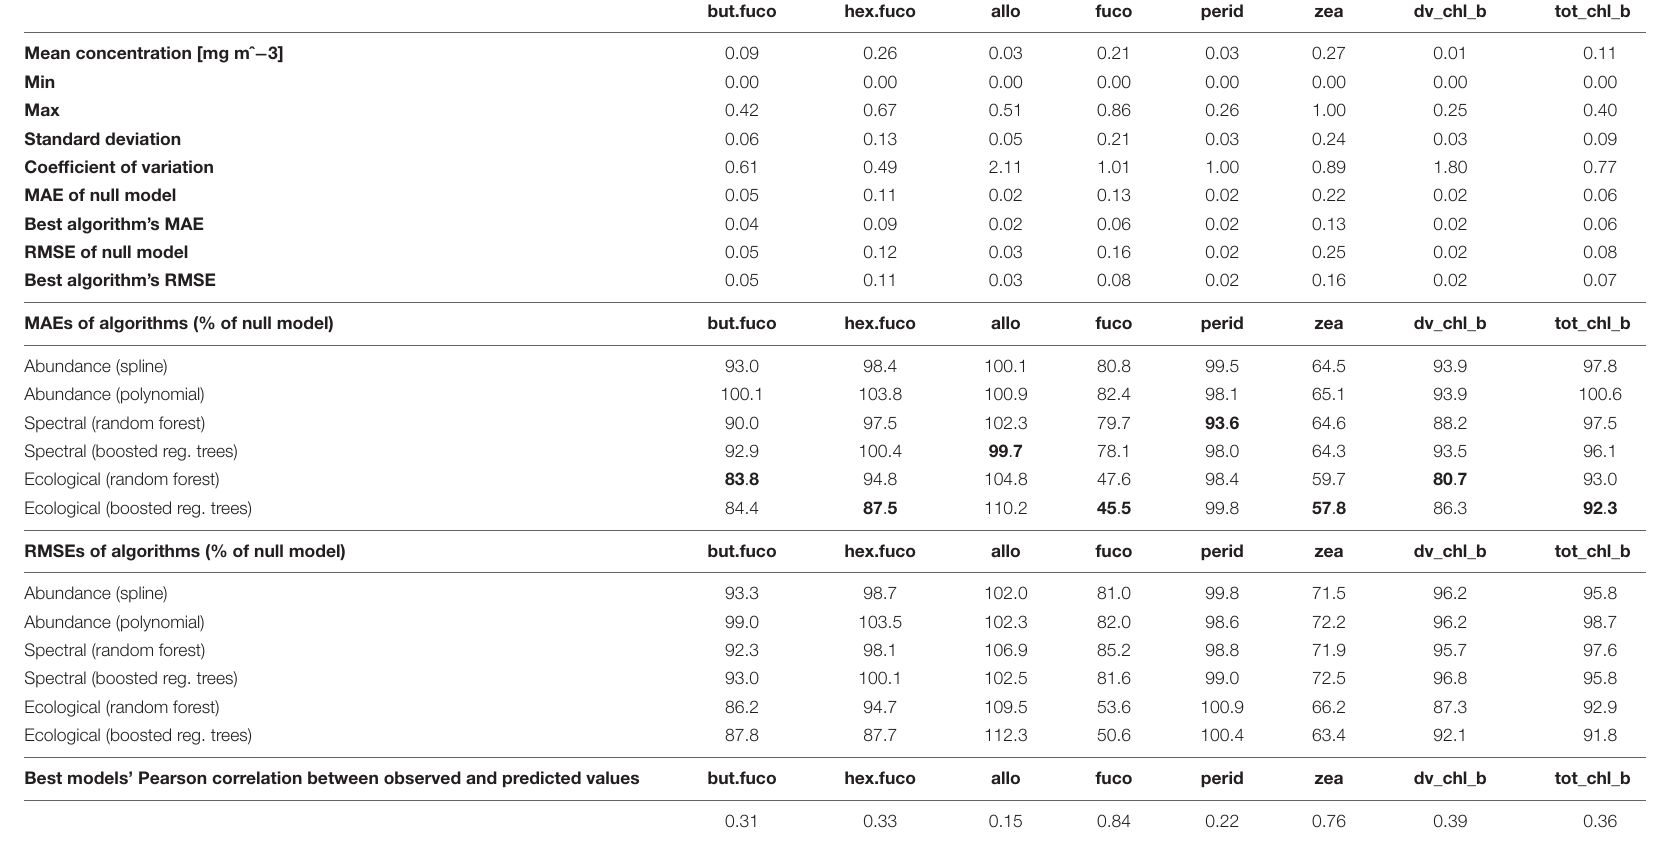
MAE, mean absolute error; RMSE, root mean squared error. The lowest MAE achieved for each pigment is emphasized in bold